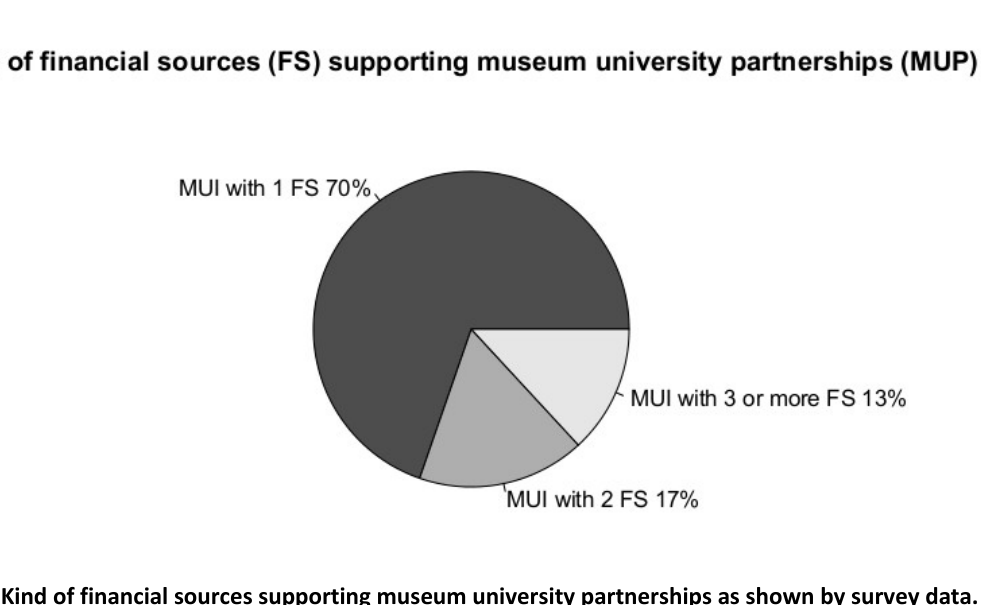
Figure 8. Number of financial sources (FS) supporting each museum university partnership (MUP) as shown by survey data.